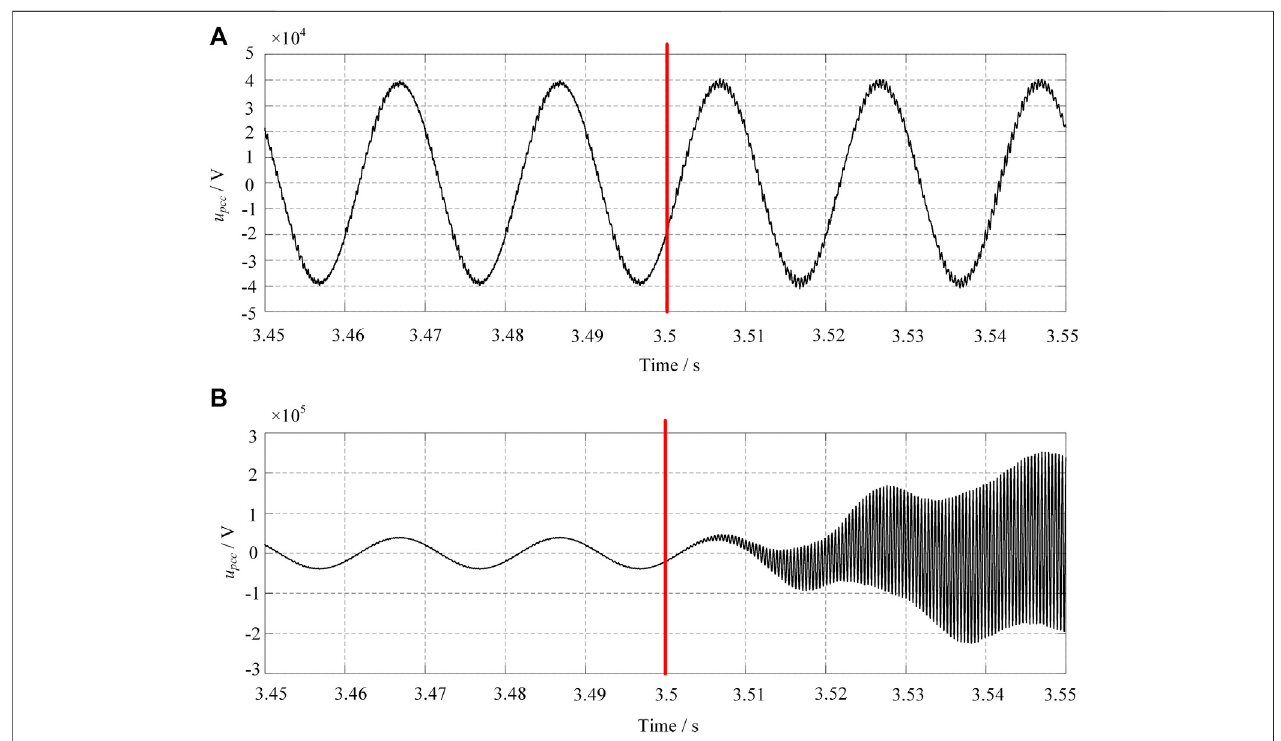
FIGURE 14 | Simulation result for case V. (A) the simulated voltage waveform for T s time delay (B) the simulated voltage waveform for 2 Ts time delay.